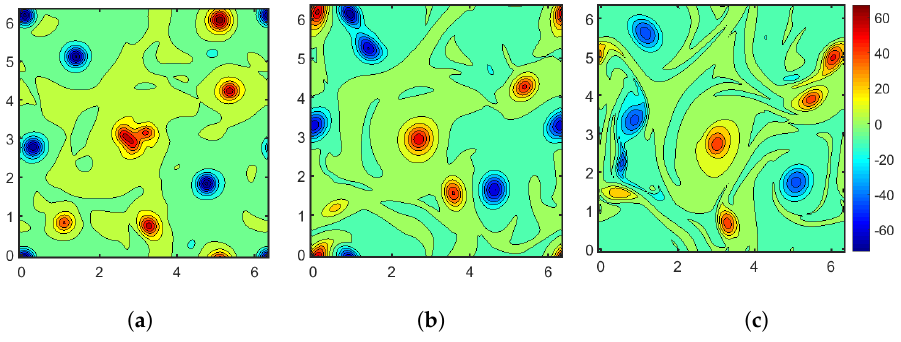
Figure 9. Vorticity contours at t ∗ = 10.42. ( a ) Filtered DNS vorticity field; ( b ) LES vorticity field with NN model; ( c ) Under-resolved vorticity field on coarse grid.